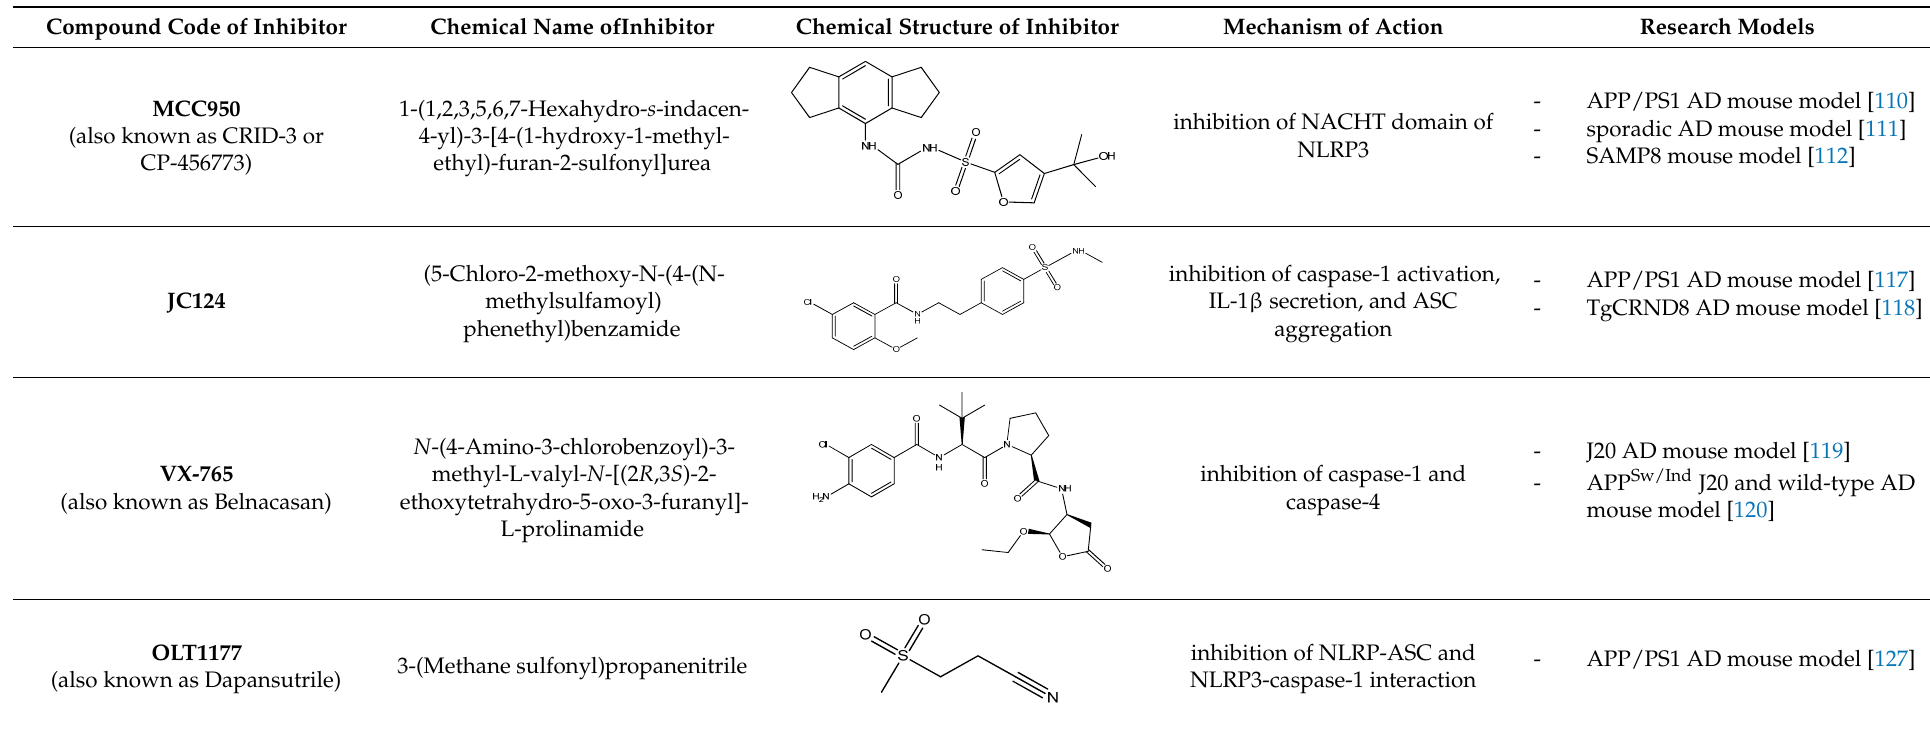
Table 1. Characterization of the most common NLRP3 inhibitors used in AD research.